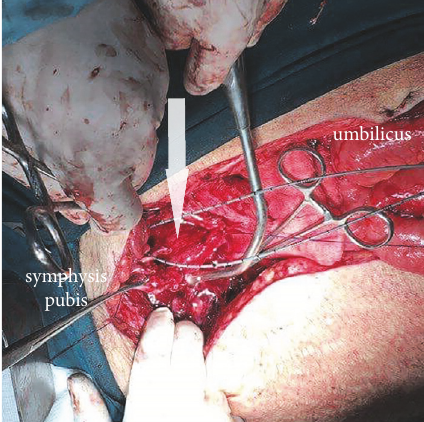
Figure 5: Preservation of both ureters and trigone (arrow) after debridement of the necrotic tissue.